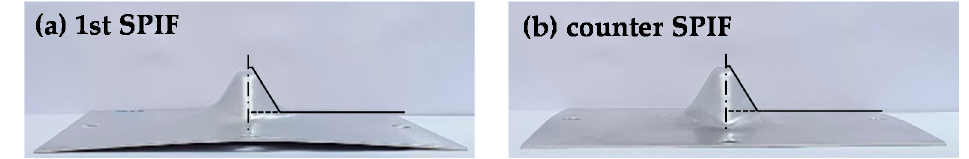
Table 6. Comparison of hull shape according to each process.